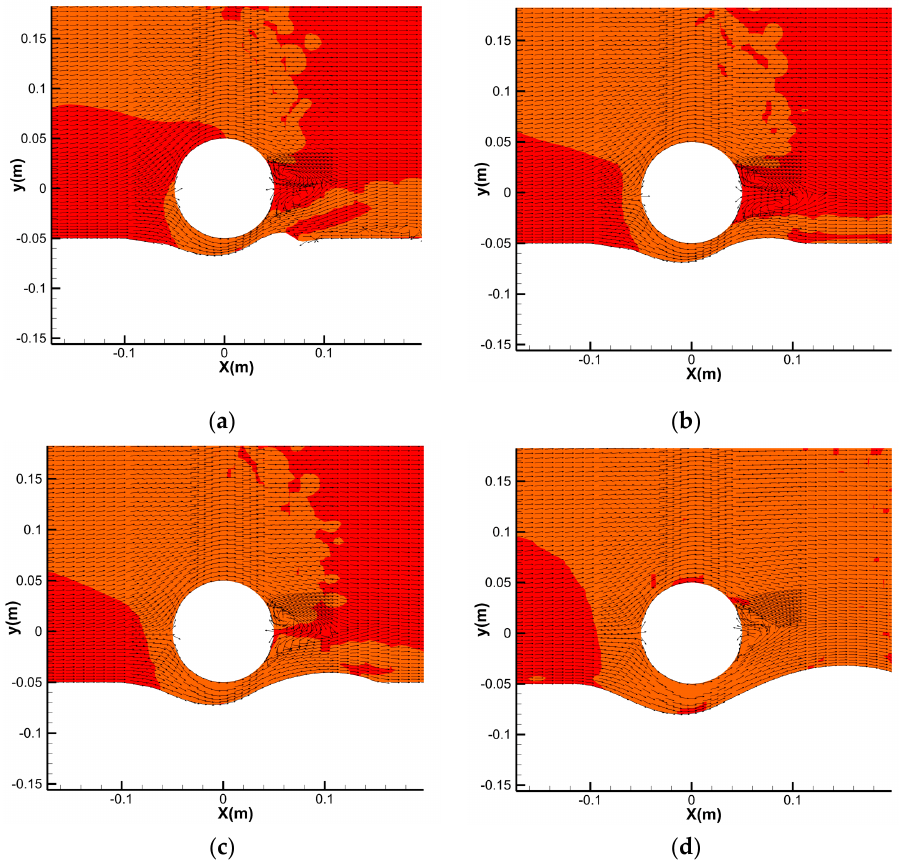
Figure 10. The velocity vector over time ( a ) 0.1 min ( b ) 0.5 min ( c ) 1 min ( d ) 5 min.